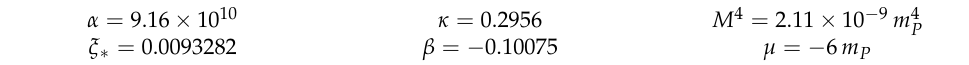
Figure 4. The parameter space κ ( ξ ∗ ) for successful inflation. The blue (dark) band depicts the region which reproduces the observed values of the spectral index and the amplitude of the cosmological perturbations (the central values of n s and A s in Equation (29)). The allowed region is depicted in orange (light band), which satisfies the bound on the tensor-to-scalar ratio r in Equation (29) and corresponds to the range of reheating efficiency in Equation (43), which in turn implies the number of efolds of remaining inflation when the cosmological scales leave the horizon ranges as N ∗ = 60–75. (We have taken α M 4 = 143.08.). Table 1. Exact values of model parameters assumed in all the